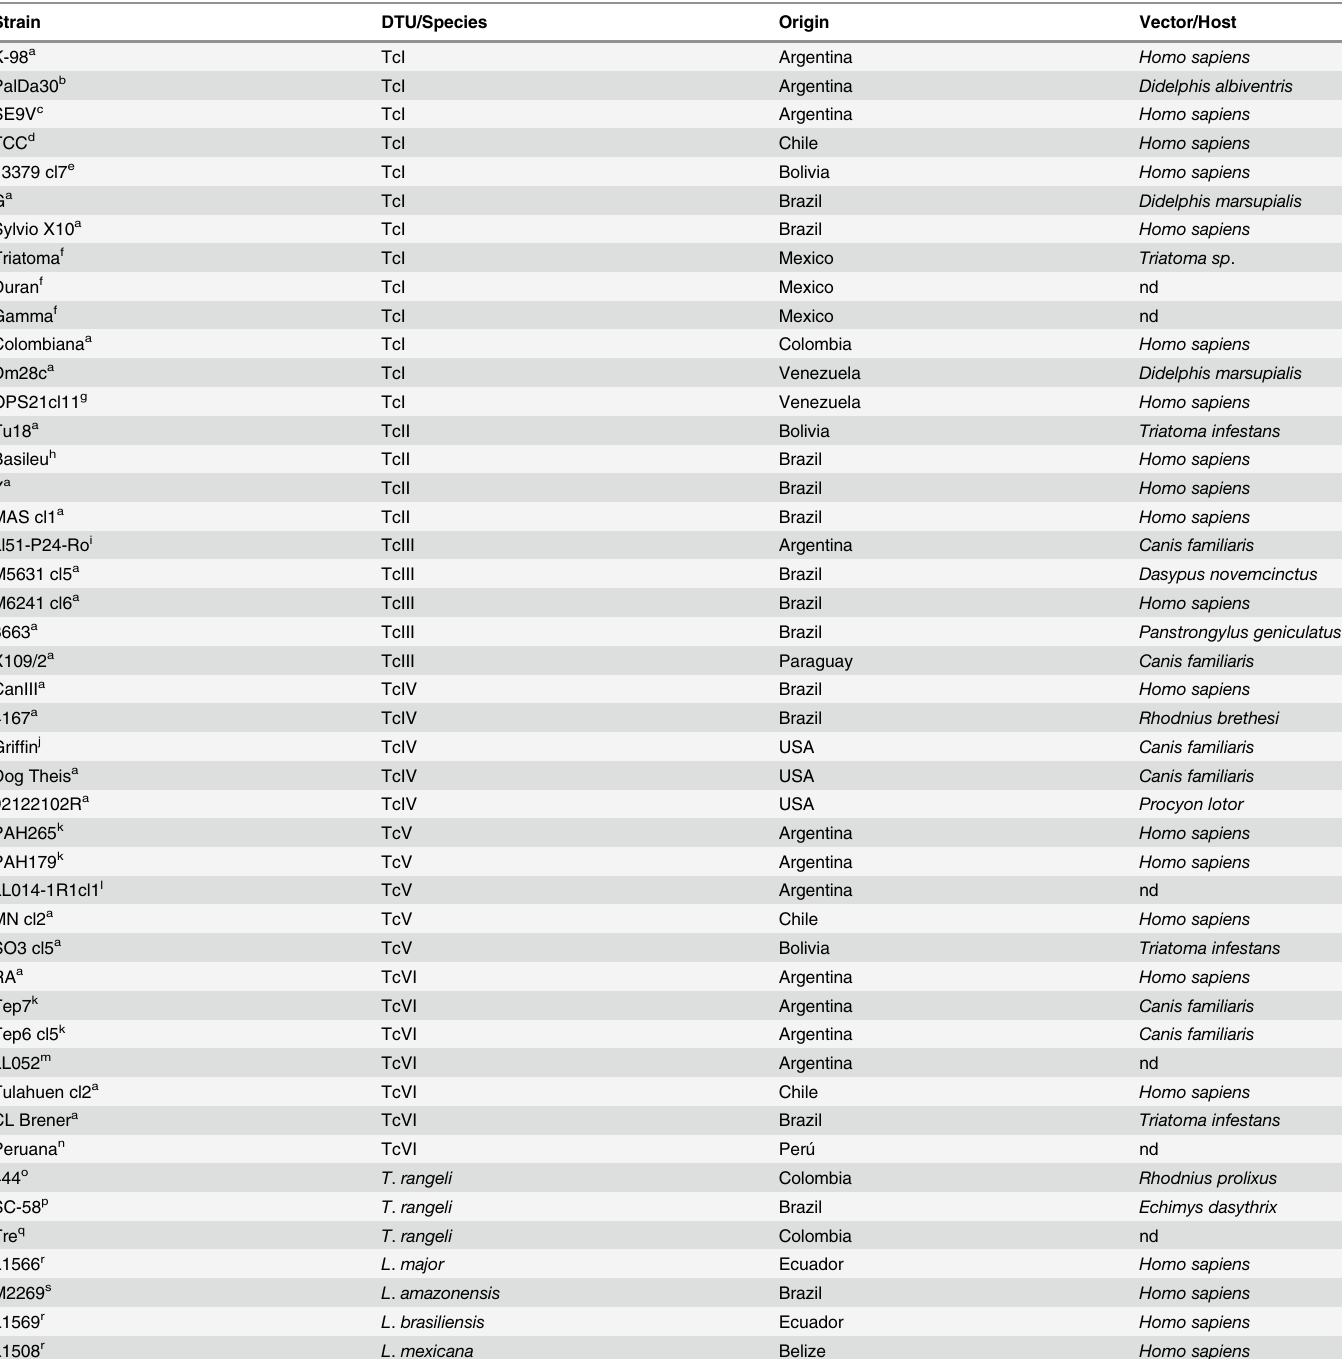
Table 1. T . cruzi , T . rangeli and Leishmania spp. isolates used to evaluate the analytical performance of the multiplex real-time PCR genotyping